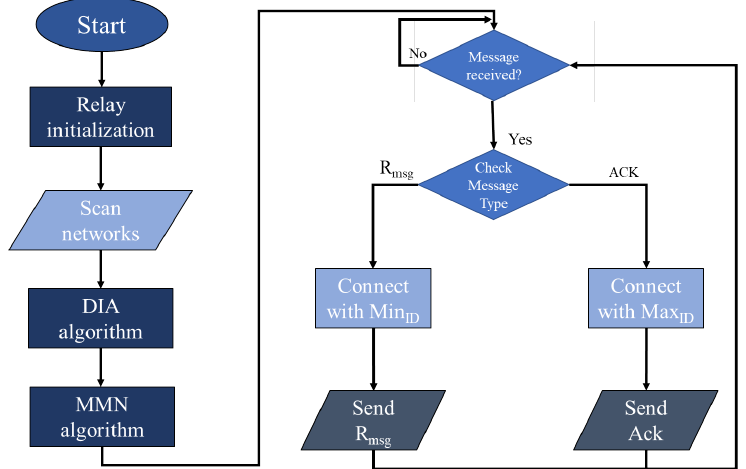
Figure 3. Flow chart of relay device.